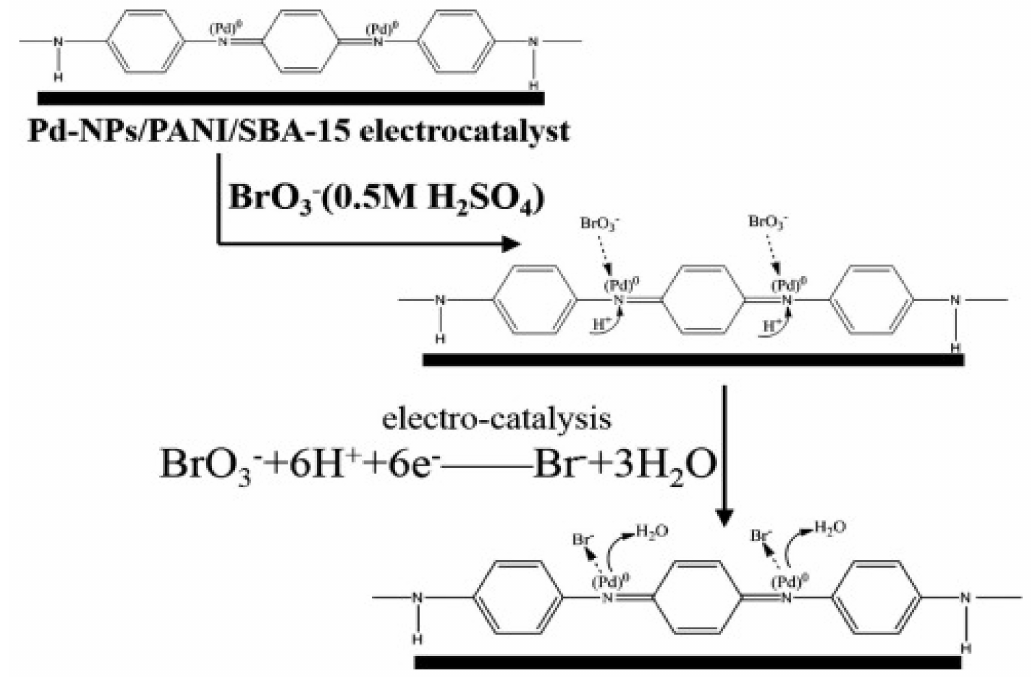
Figure 4. Schematic representation of the proposed electrocatalytic reduction process of BrO 3 at the Pd-NPs/PANI/SBA-15 interface (adapted from [60] with